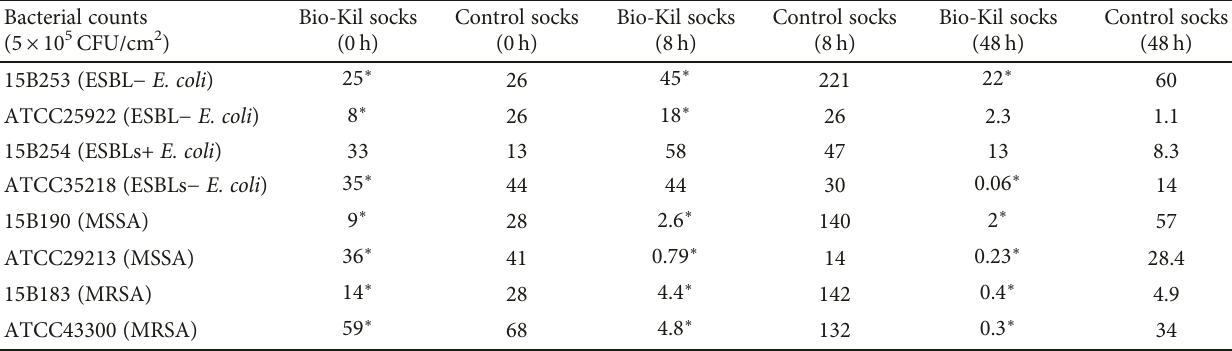
Table 1: Bacterial counts in Bio-Kil socks and control socks in bacterial strain